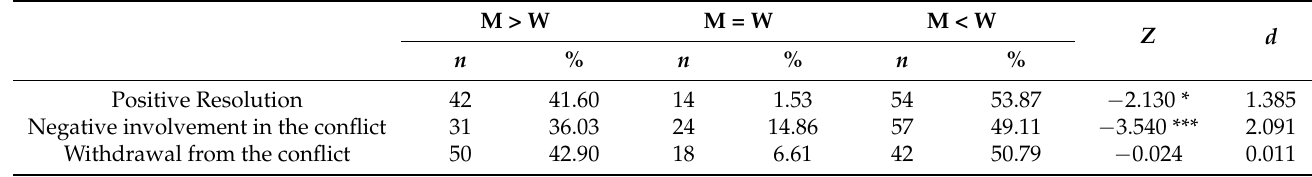
Table 7. Agreement on the frequency of conflict resolution strategies (CRSI) in violent couples. Proportion of the couples that report a greater, equal, or lesser use of